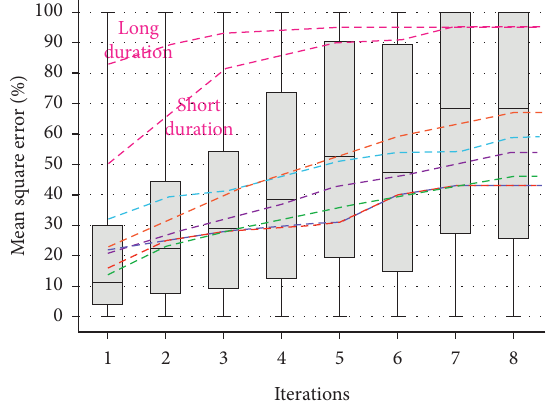
Figure 4: The mean square error with iterations predicted by the clustering